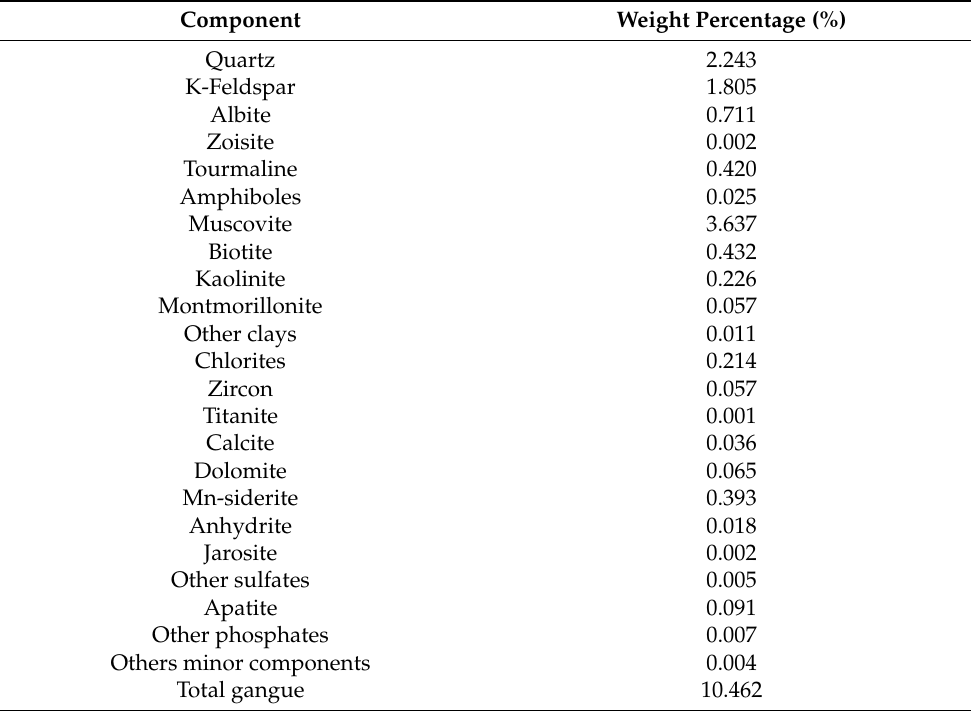
Table 2. Weight percentages of gangue components of the mineral